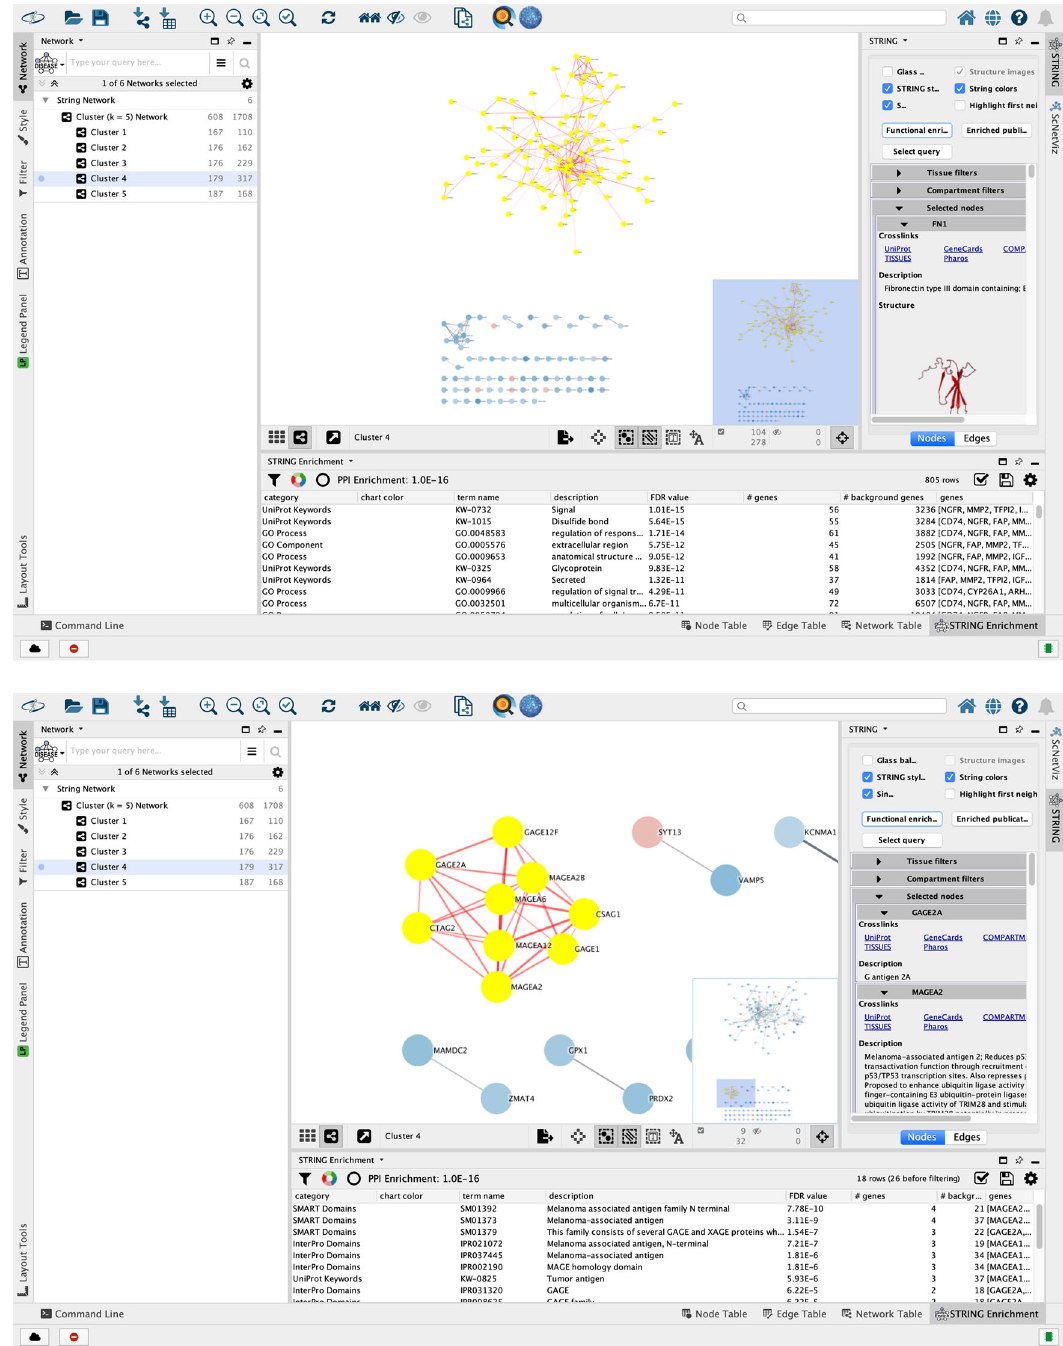
Figure3.ThenetworksfromtheSTRINGdatabasearedisplayedinthemainCytoscapewindow. Theillustration shows the interaction network for genes specific to the group labeled ” Cluster 4 ” . Users can filter the complete network using the network analysis tools in Cytoscape. (a) A selection of the largest connected component, which is highlighted with yellow nodes and red edges. (b) Other sub-networks might also be of interest. The second-largest connected component of Cluster 4 shows enrichment of melanoma-associated terms, which is consistent with the fact that this experiment is on melanoma cell lines.